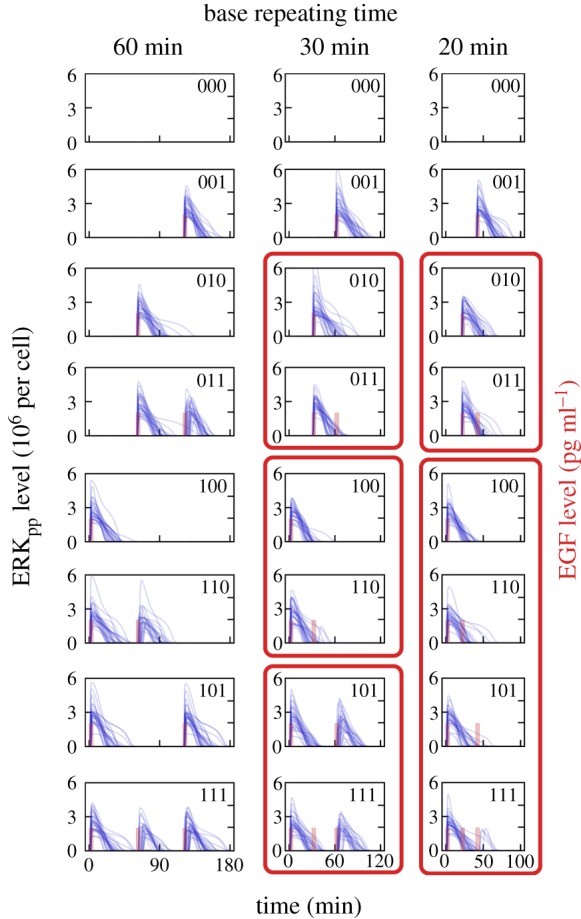
Responses to eight possible series of three pulses having amplitude of either ‘0’ (‘pseudo-pulse’) or ‘1’ (100 pg ml−1 in dimensional units). For each base repeating time Ti (60, 30 or 20 min) and each pulse sequence, 30 independent numerical simulations were performed with σ = 0.3, μ0 = 0.03. For T = 30 min and T = 20 min, the sequences transmitted to the same output sequence are grouped and encircled by bold frames. The first element of each group is accurately transmitted and will be referred to as a group representative. (Online version in colour.)